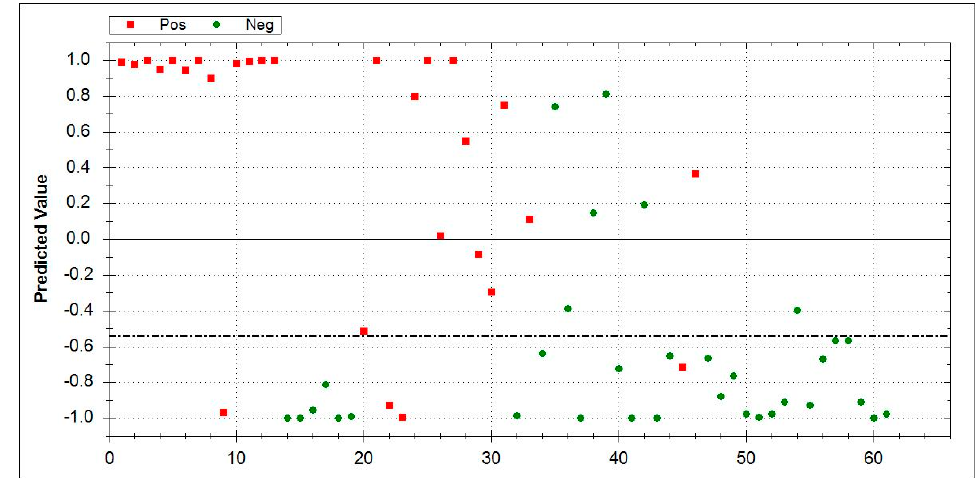
Figure 3. Direct comparison between COP ( n = 28, red squares) vs. HC ( n = 33, green dots). COP area 0–1: Red squares indicate correctly recognized COP patients while green dots denote false positive patients. HC area 0–1: Green dots represent correctly identified healthy controls, while red squares mark false negative results. The dotted line is inserted for values around the threshold where there is doubt about which side it tends to, and, hence, reflects an area of uncertainty. Abbreviations: COP-cryptogenic organizing pneumonia, HC- healthy controls.